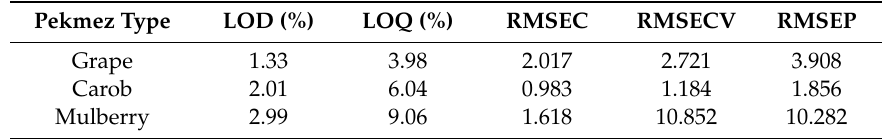
Table 3. Parameters of PLS models of grape, carob and mulberry pekmez samples. Pekmez Type LOD (%) LOQ